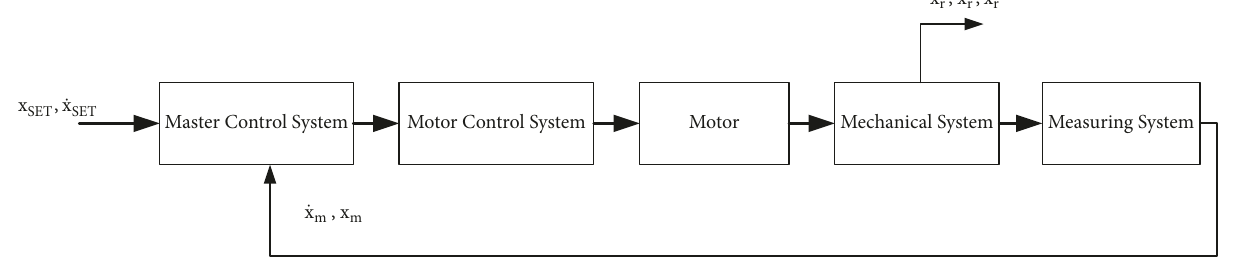
Figure 1: Functional diagram of the electric vehicle drive